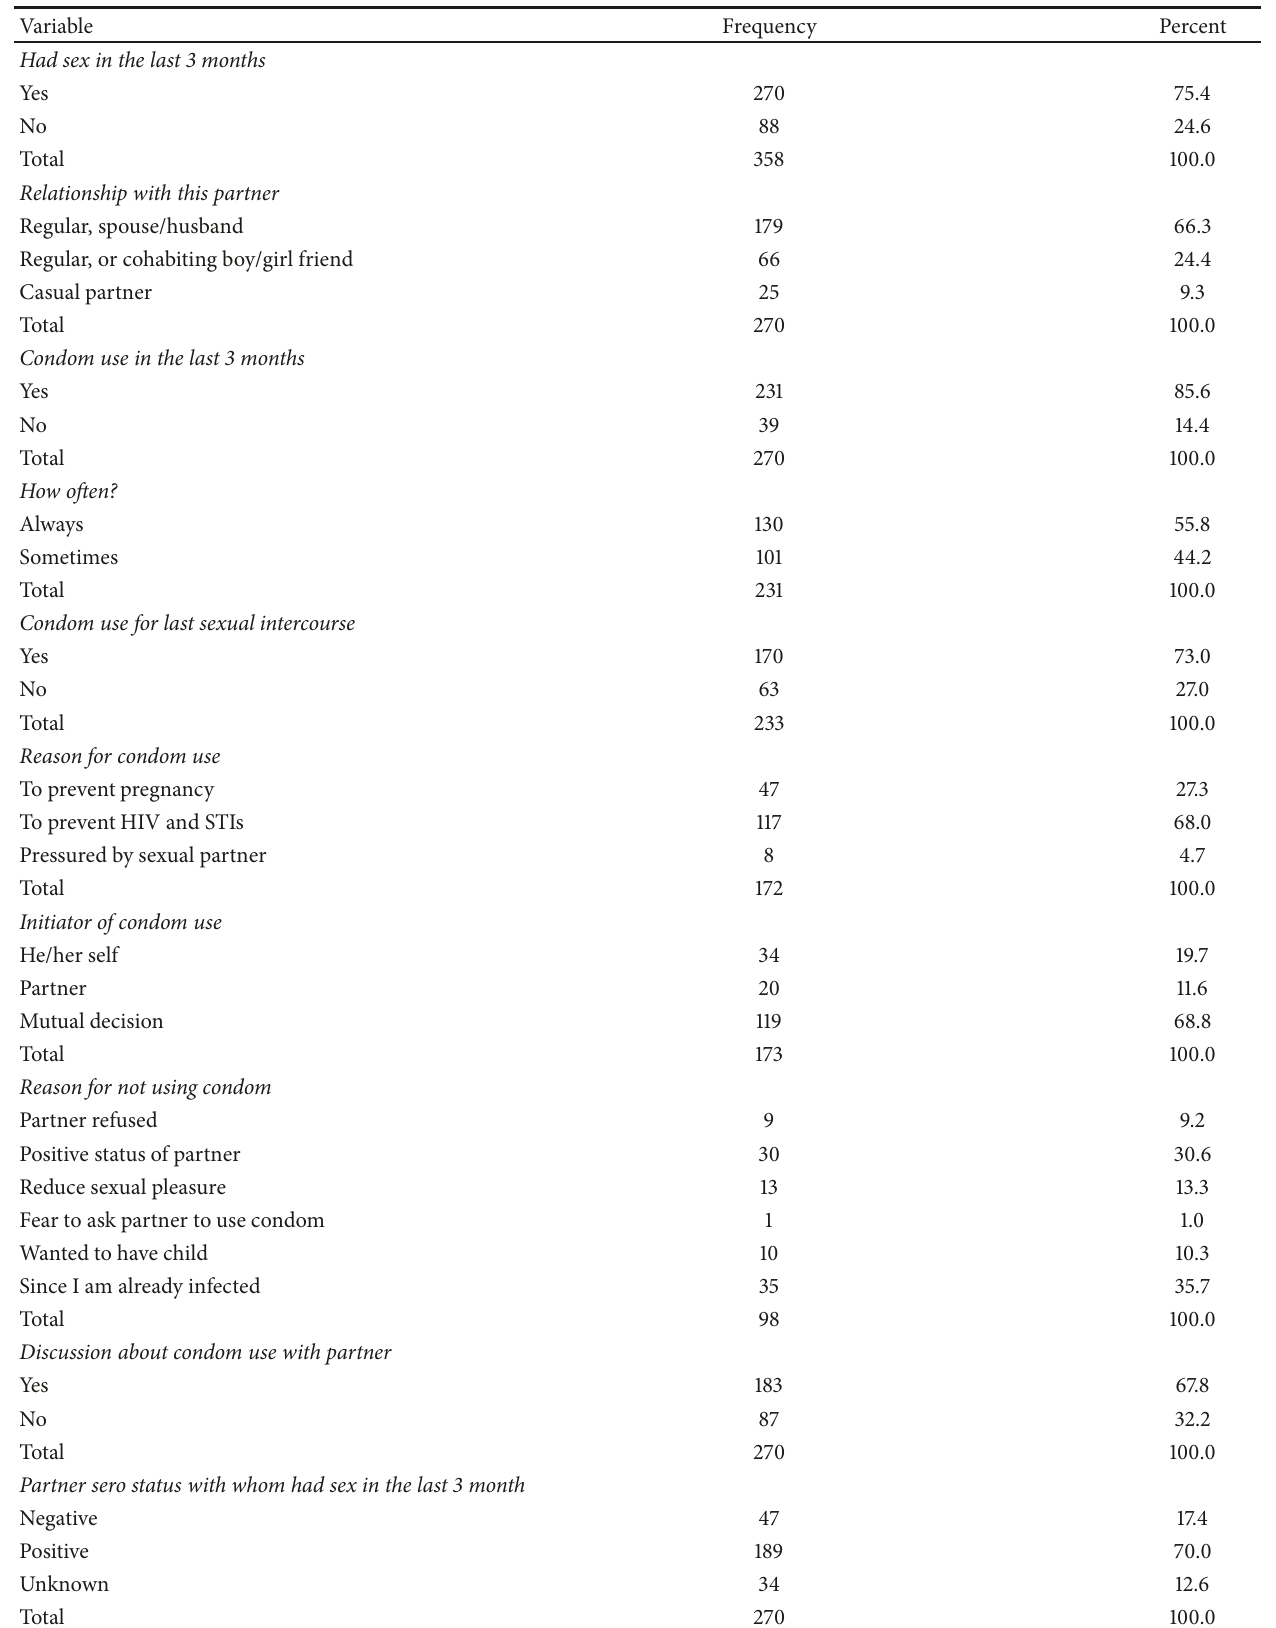
Table 3: Sexual behavior and condom use of HIV infected persons in condom use survey, Kolladiba health center North West Ethiopia, 2016.